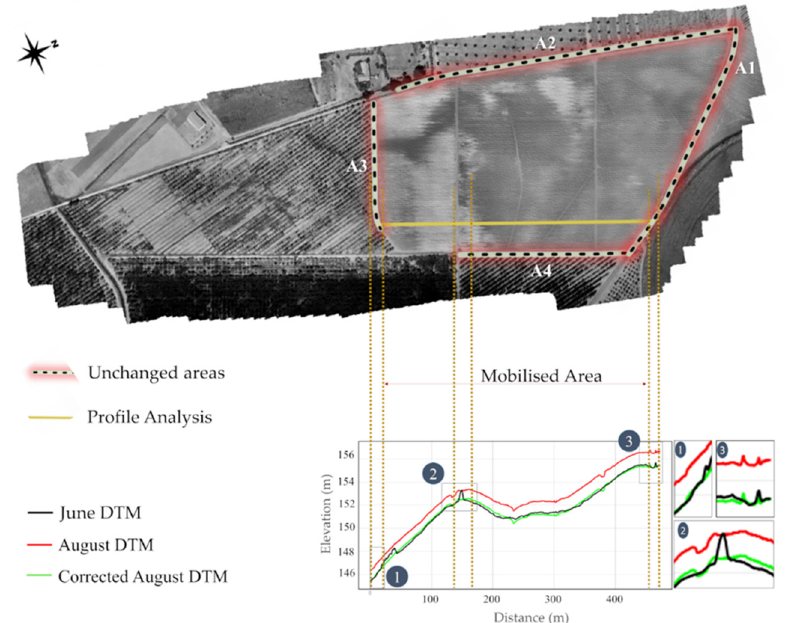
Figure 11. Location of unchanged areas. Terrain profile analysis for each DTM crossing two un- changed areas (A1 and A3) and the soil tillage area.